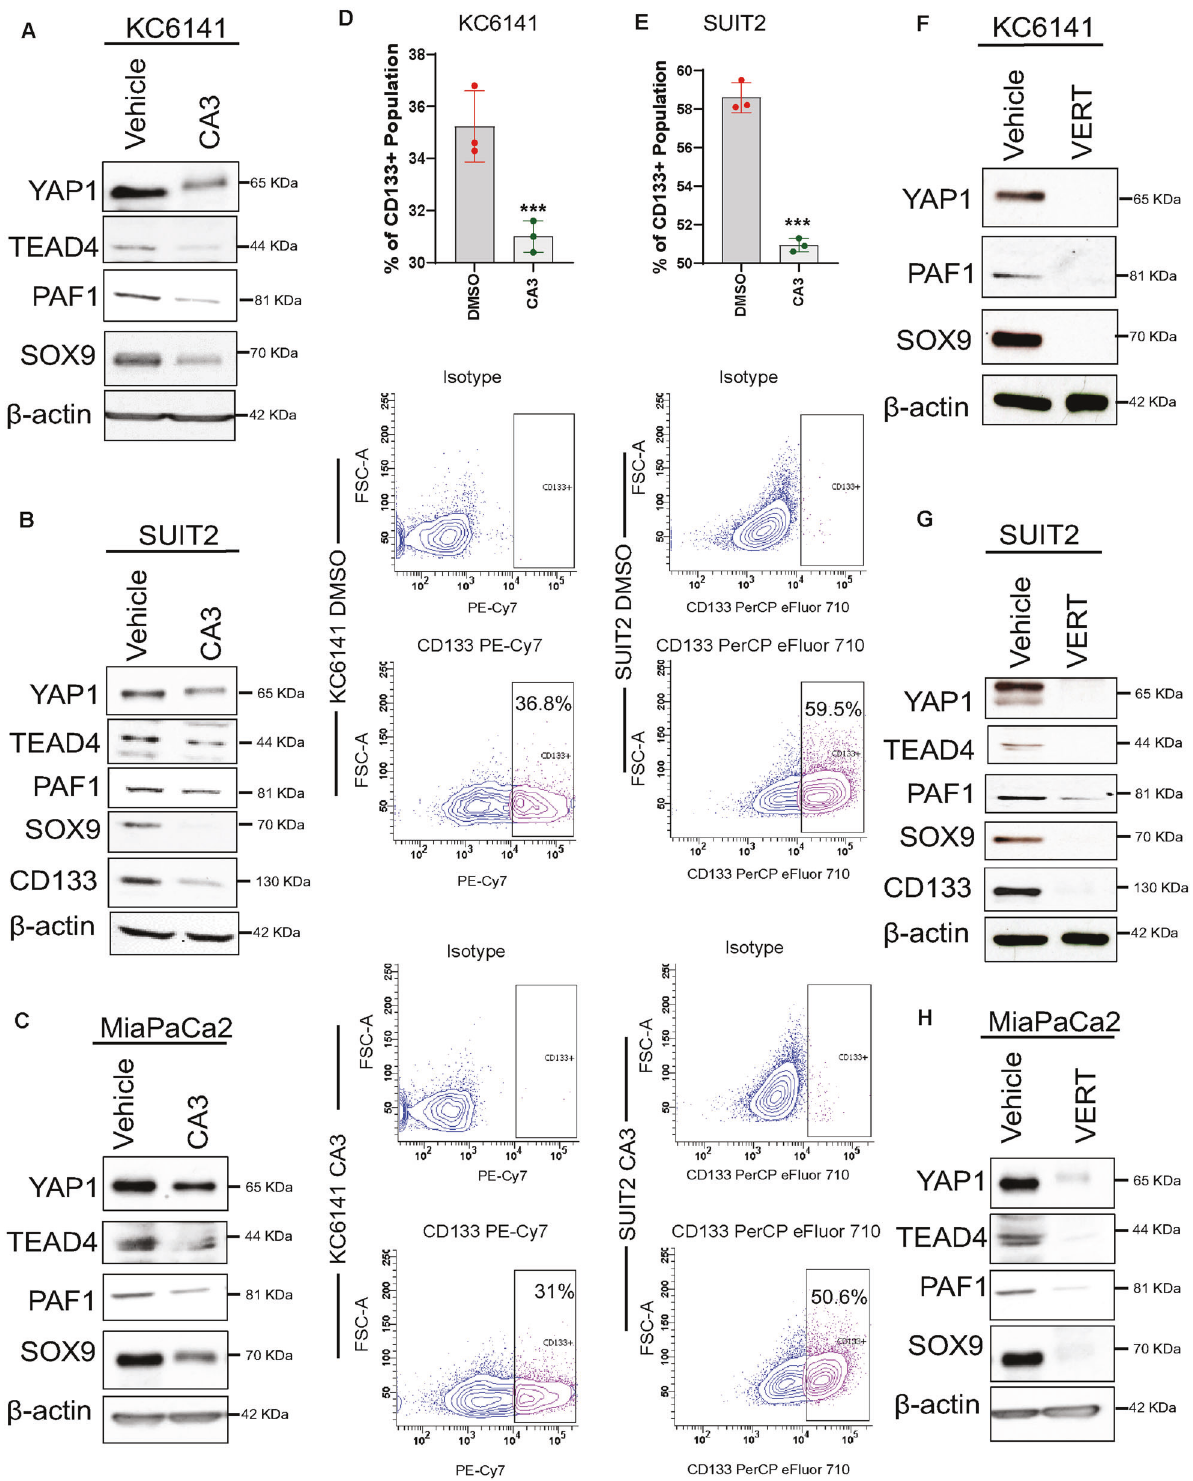
Fig. 4 CA3 and vertepor fi n inhibit YAP1/TEAD4/PAF1 and reduce cancer stem cell markers and features. A – C , Western blot analysis of protein expression levels of PAF1, YAP1, TEAD4, SOX9, and CD133 in indicated cell lines treated with vehicle control or CA3 (1 µM, 48 h). β -actin was used as a control. D , E Flow cytometry analysis of CD133 + population in KC6141 and SUIT2 cell lines with or without CA3 treatment. Bar graphs show the percentage of the CD133 + population. Data are mean ± SD, n = 3. F – H Western blot analysis of protein expression levels of PAF1, YAP1, TEAD4, SOX9, and CD133 in indicated cell lines treated with vehicle control or vertepor fi n (2 µM, 48 h). β -actin was used as a control. For all panels, signi fi cance was determined with a student ’ s t test. * p < 0.05, ** p < 0.01, *** p < 0.001, ns non-signi fi cant, p > 0.05.